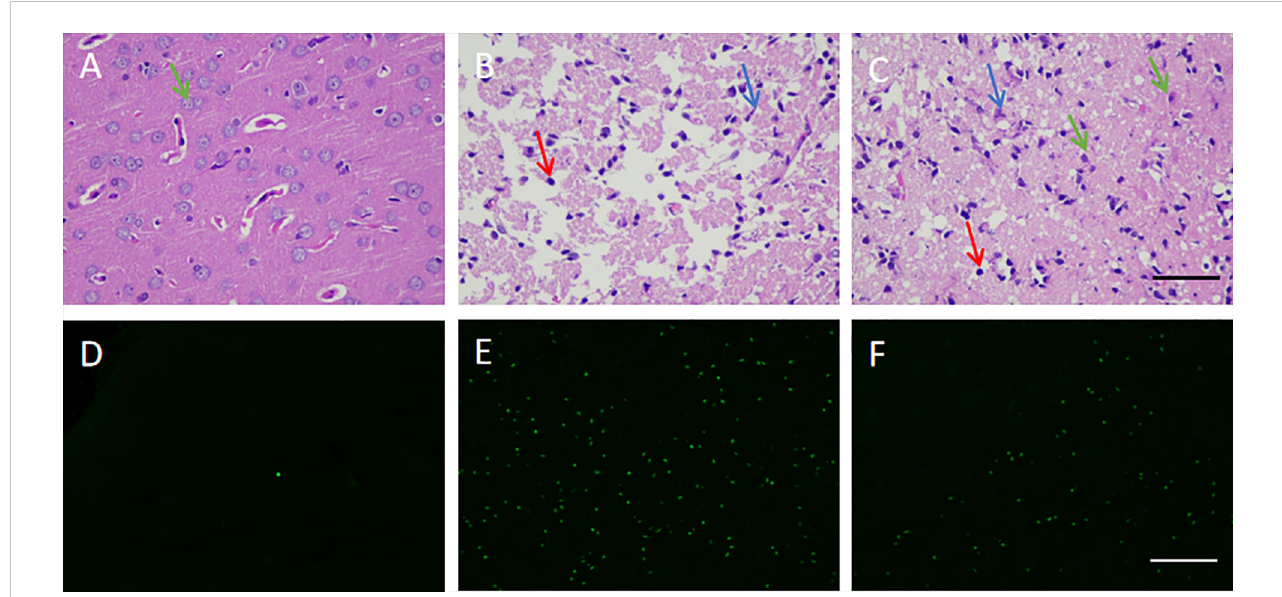
FIGURE 5 Effect of hUCMSCs on the pathological structure and apoptosis of brain tissues of MCAO rats. (A – C) HE staining results of the normal, model, and treatment groups on d14 after administration, respectively. The staining magni fi cation is 400 times and the scale is set at 2.5 µm (green arrow: neuronal cells; red arrow: microglial cells; blue arrow: apoptotic neuronal cells); (D – F) tunel staining results of the normal, model, and treatment groups on d14 after administration, respectively. The staining magni fi cation is 400 times and the scale is set at 2.5 µm.